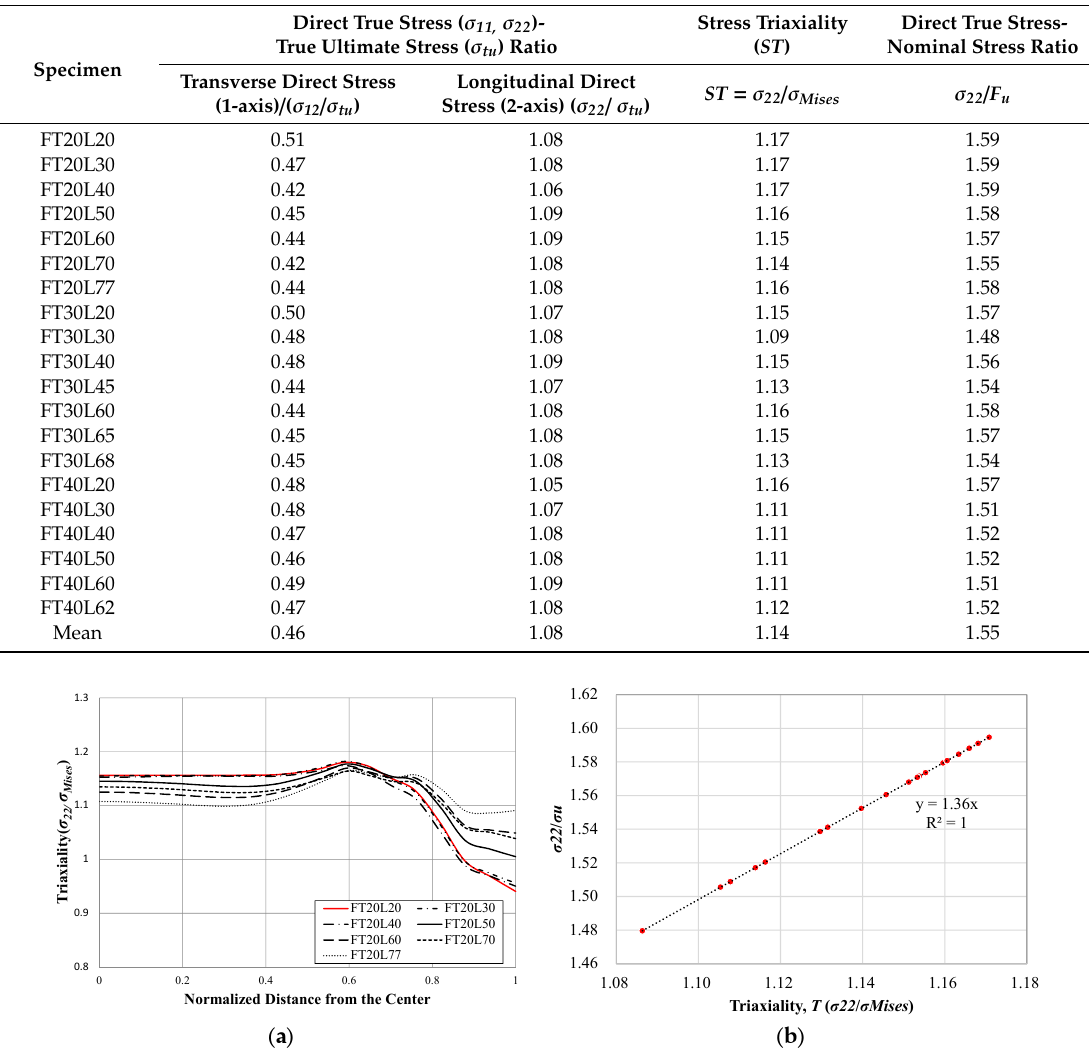
Table 6. Stress and tensile stress factor in tensile section.